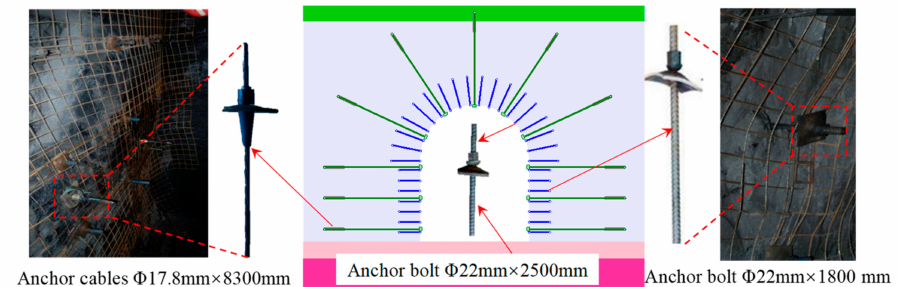
Figure 18. Chamber support scheme.